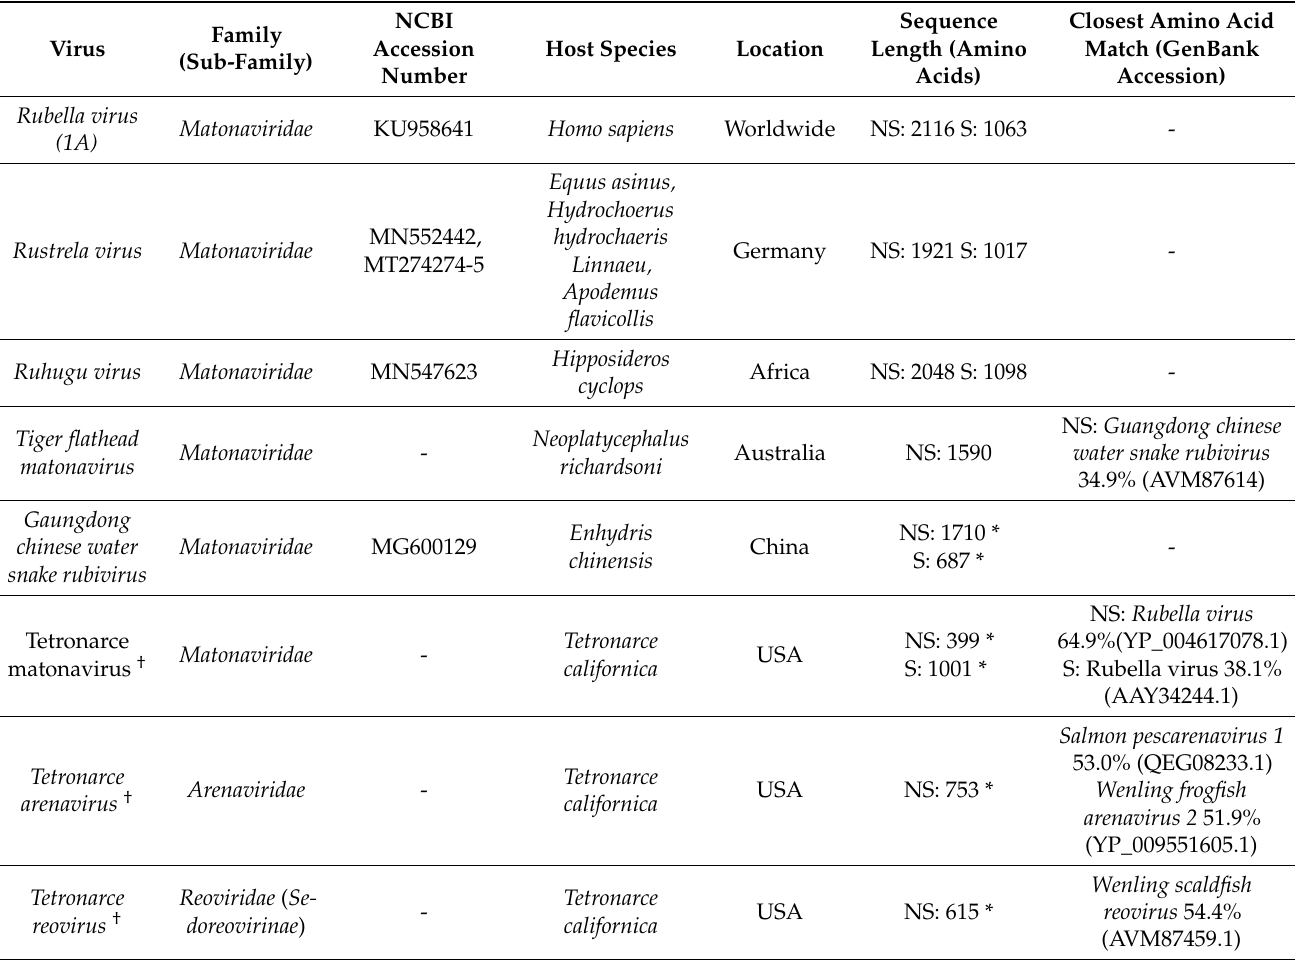
Table 1. Novel Tetronarce viruses and Matonaviridae referenced in this